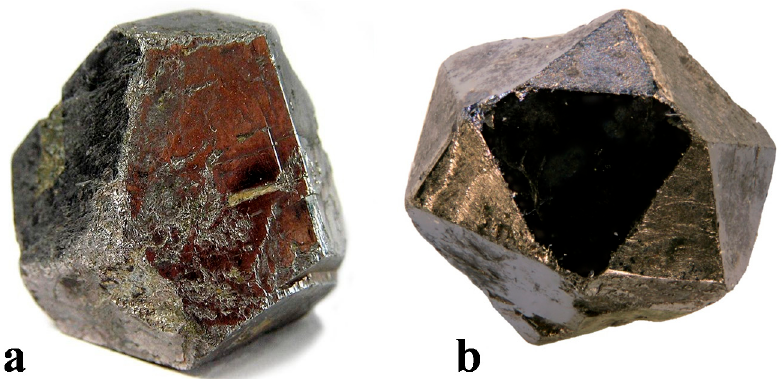
Figure 10. Cobaltite crystals with ( a ) elongated pyritohedral shape. Size: 2.5 × 2.3 × 2.2 cm (picture from Rob Lavinsky) and ( b ) icosahedral shape. Size ≈ 2.5 mm (crystal and picture courtesy of the Museo Geominero (IGME), Madrid, Spain).